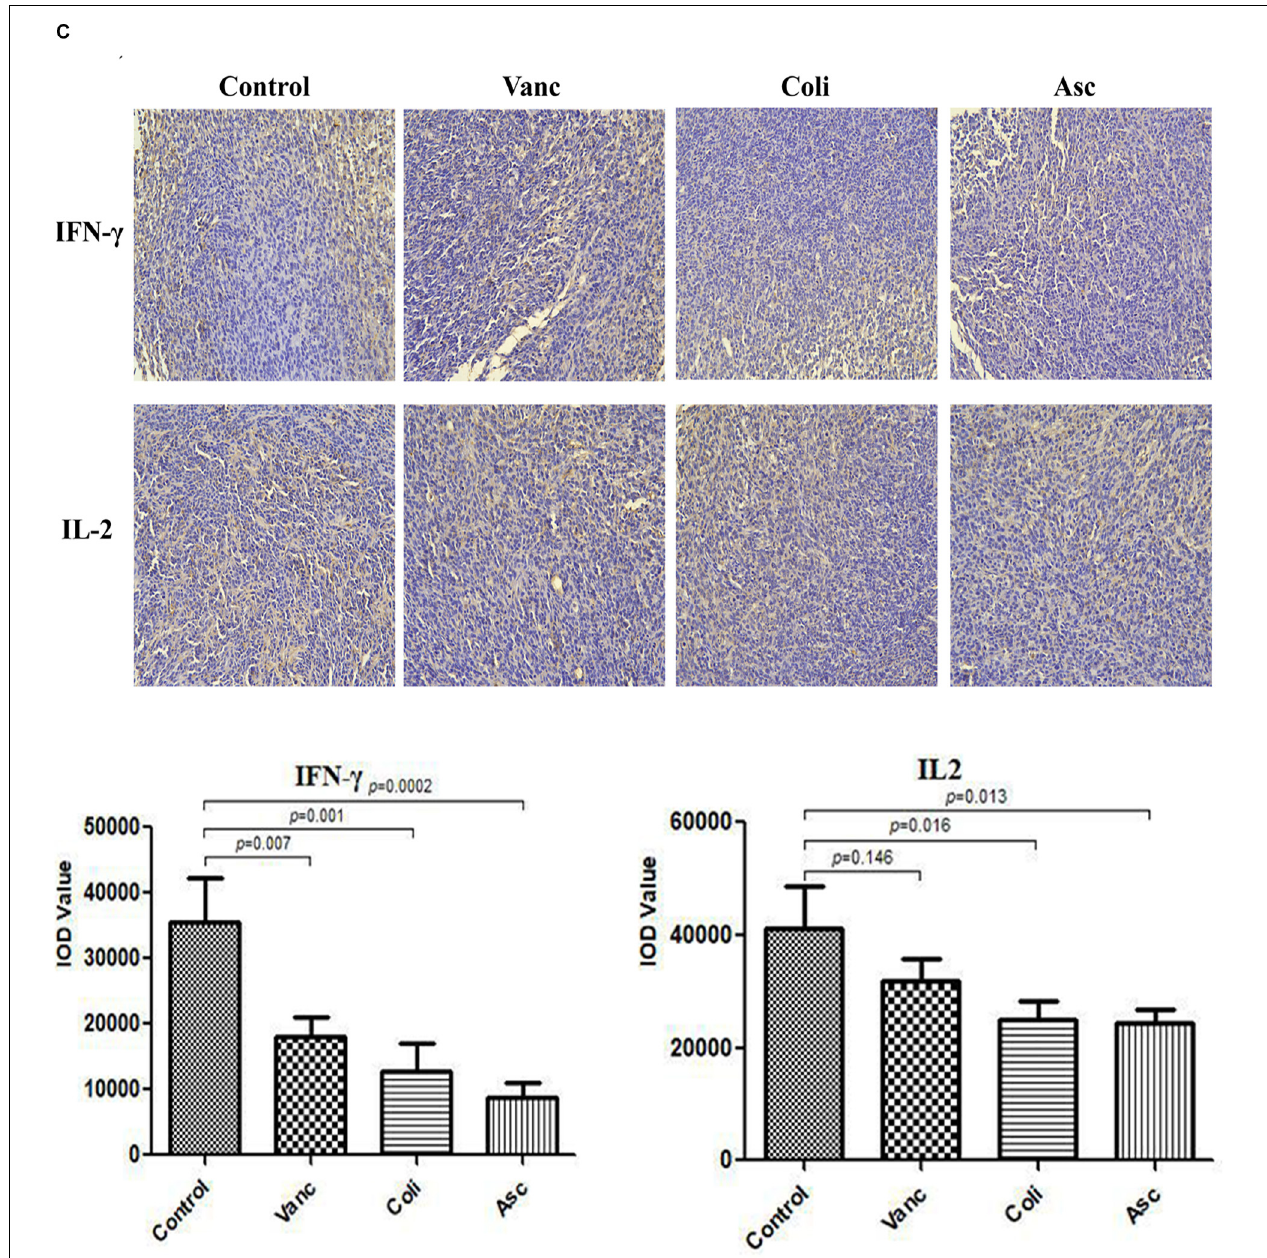
FIGURE 6 | Gut microbiota changes the expression of immune factors in the tumor microenvironment. (A) Bar graph of PD-1, TGF- β , IFN- γ , IL-2, IL-6, and IL-17 in by Elisa tumor samples. (B) The number of CD4 + and CD8 + T cell were detected by flow cytometry. (C) Representative immunohistochemistry images on tumor